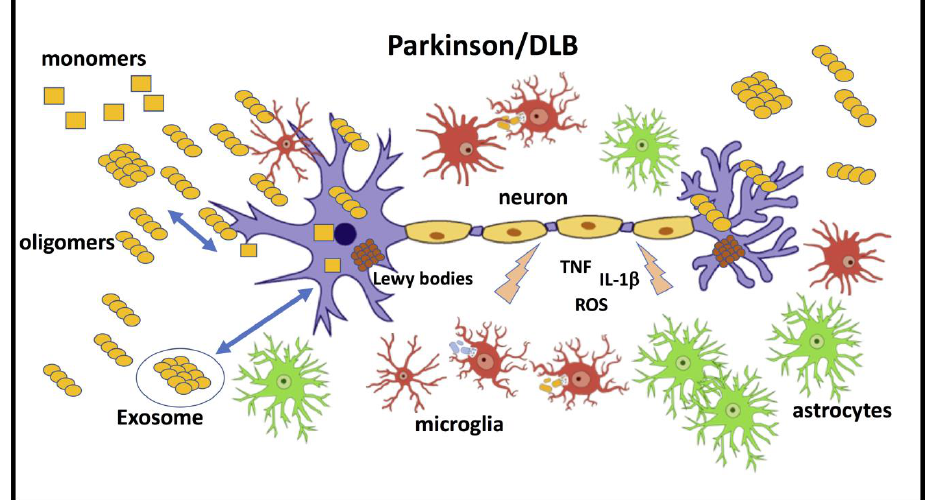
Figure 1. The pathological scenario in synucleinopathies . α -Syn in various forms, monomeric, oligomeric and fibrils, interact with neurons and glial cells. Neuronal dysfunction is induced by direct α -Syn oligomers, originating from outside or inside the cells. The permanent activation of microglial cells can induce the production of factors with detrimental effects on neuronal function, and astrocyte activation or dysfunction may contribute to neuronal damage.